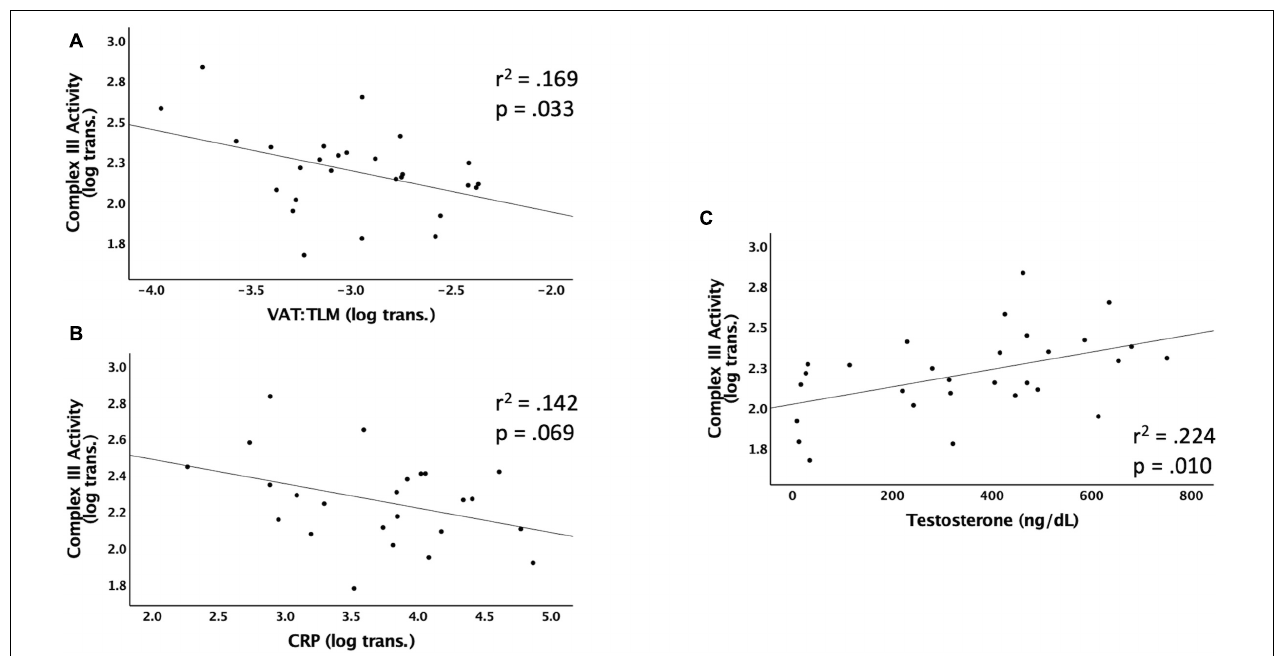
FIGURE 3 | Linear regressions predicting Complex III activity. Data that were not normally distributed were log-transformed to permit the use of parametric statistics. The log transformed values of Complex III enzyme activity are plotted on the Y axis against the predicted values for each variable on the X axis. (A) VAT